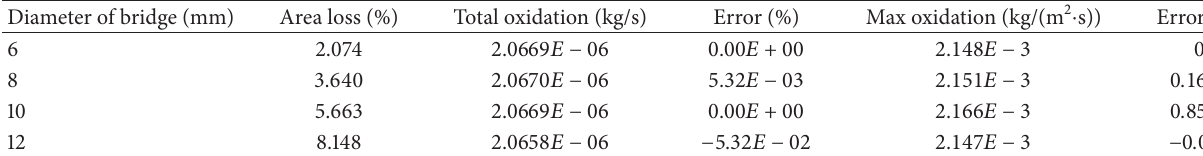
Table 2: Results of cases with different bridge.